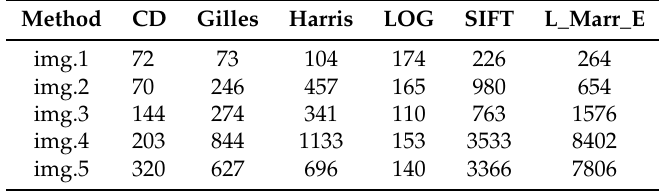
Table 2. Feature point extraction results under different kinds of algorithms.